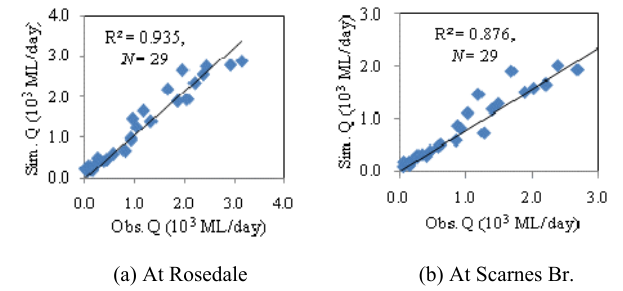
Fig. 20. Correlation of observed and simulated water flow at Latrobe River ( N = number of observations, ML=Mega liters).